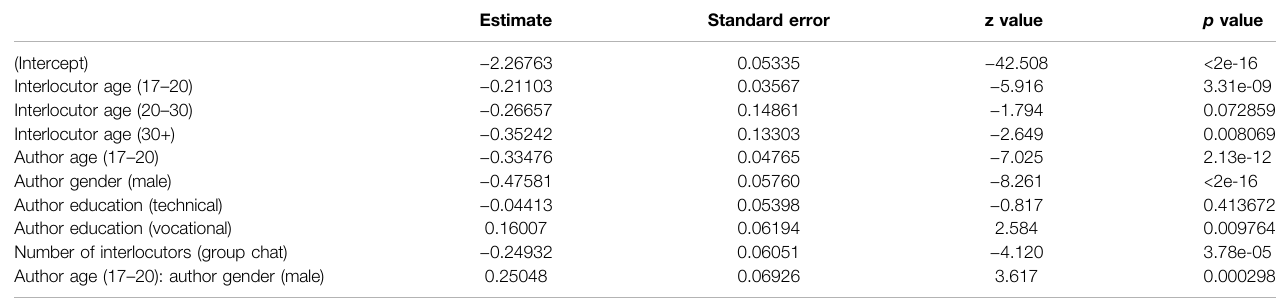
TABLE 4 | Expressiveness per interlocutor age: Fixed effects 9 .